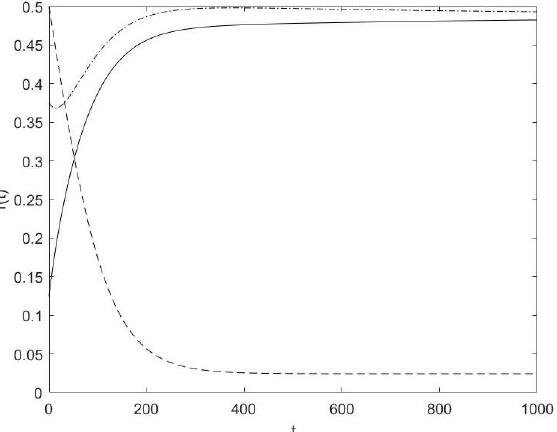
Figure 3. From top left to bottom B i dashed, f 3 full.